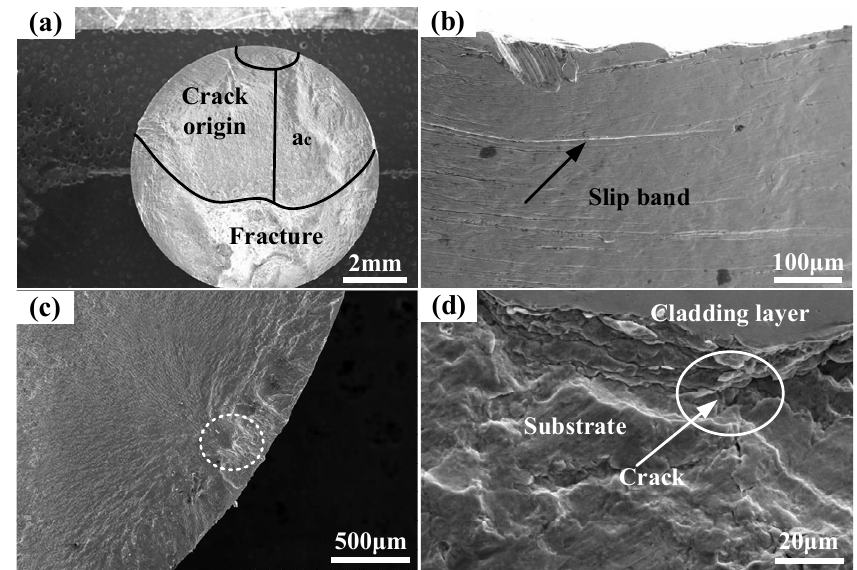
Figure 16. Fracture morphology of different cladding layers. ( a , b ) Base material; ( c , d ) FeCrNiMoRE cladding layer.